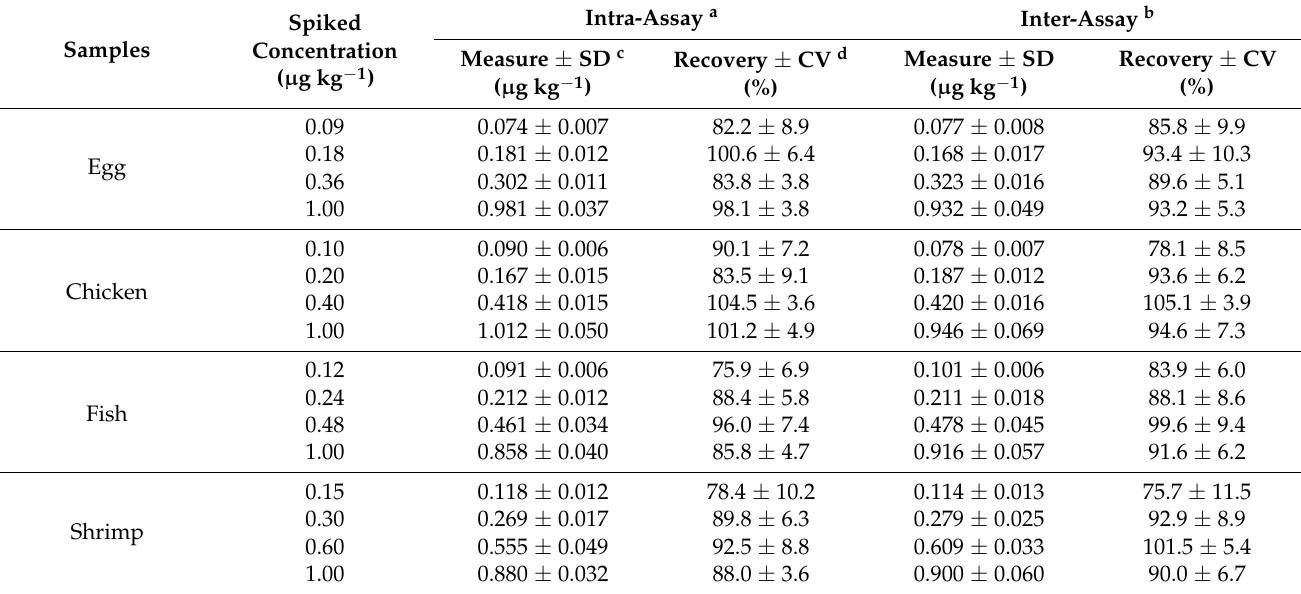
Table 2. Recovery and precision of SEM added in egg, chicken, fish, and